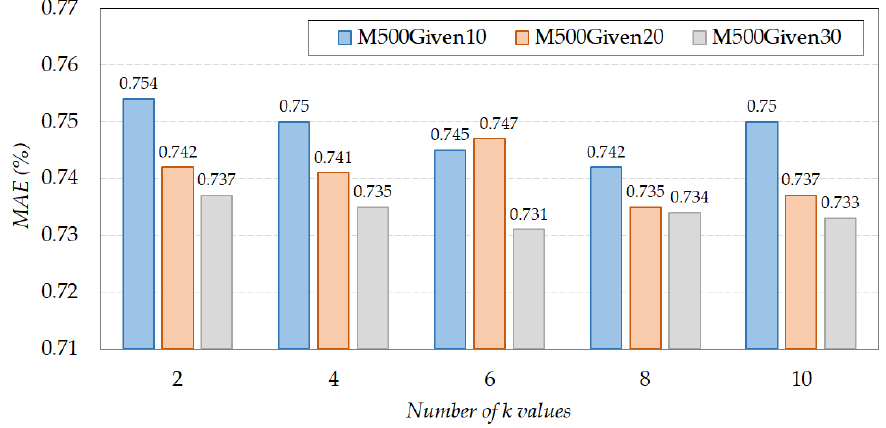
Figure 7. The prediction accuracy of k-RRI as number of k values varies.